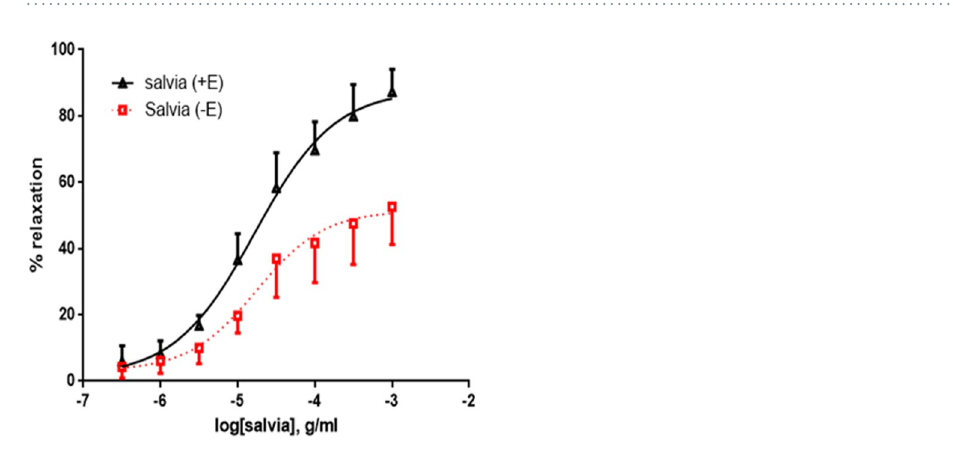
Figure 2. Effect of SF extract on vasorelaxation of aortic rings. Cumulative dose-dependent curves for SF- induced relaxation and of the vehicle (ethanol) in rat aortic rings. n = 7.